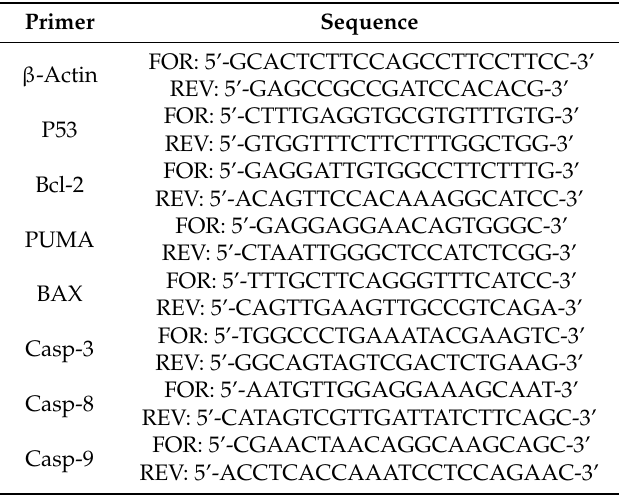
Table 1. Primers used for real-time